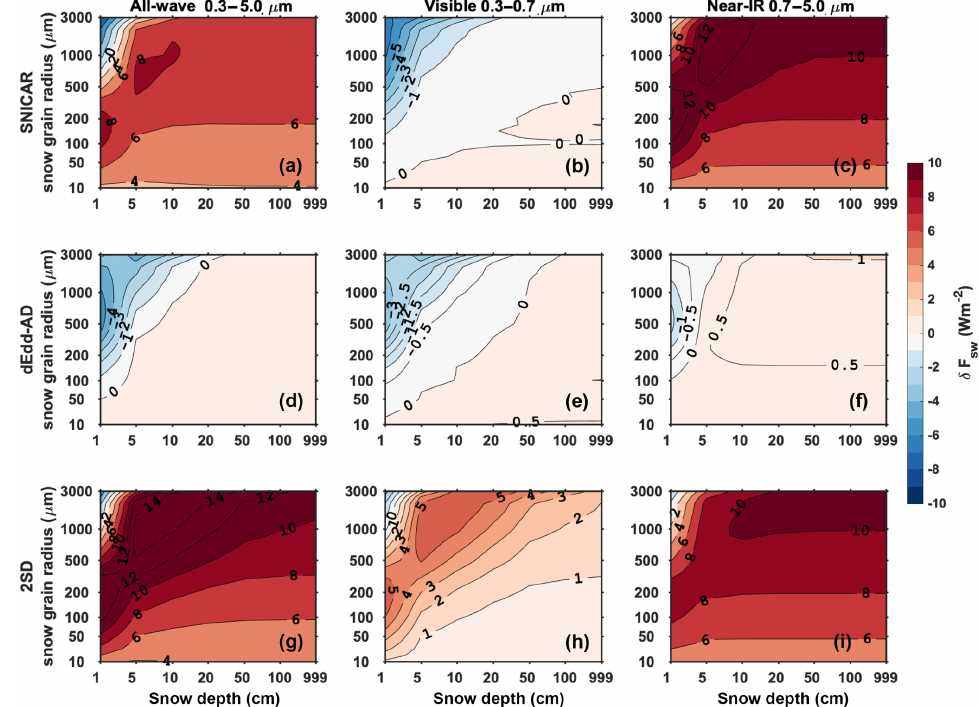
Figure 9. Error in reflected diffuse solar flux given albedo errors shown in Fig. 6.